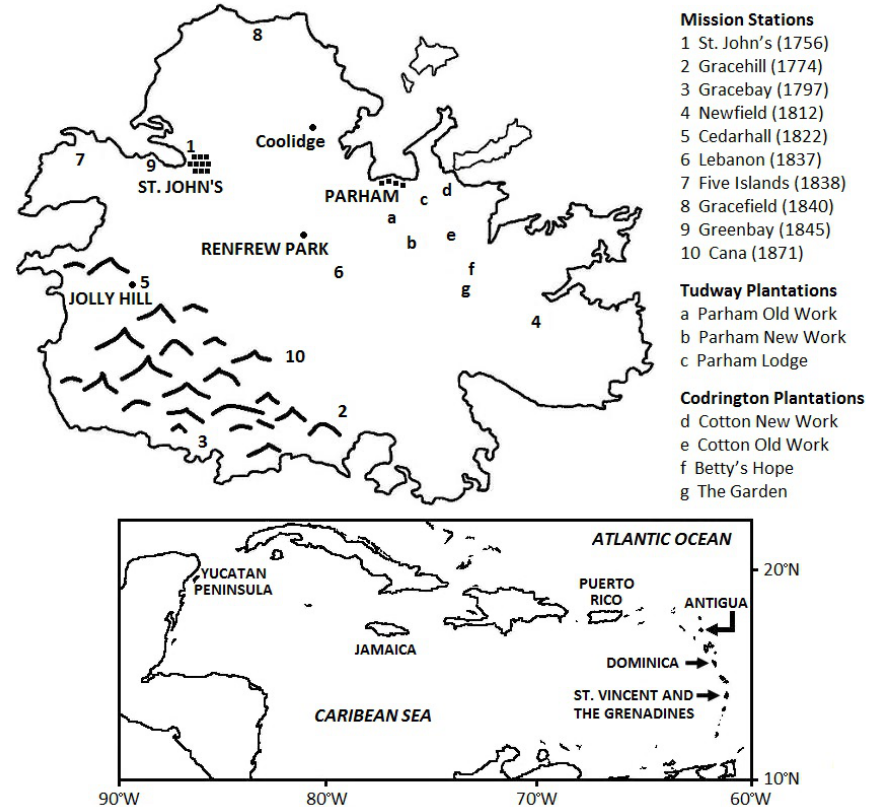
Fig. 1. Map displaying locations mentioned in the text. Dates of mission station establishment shown in brackets.